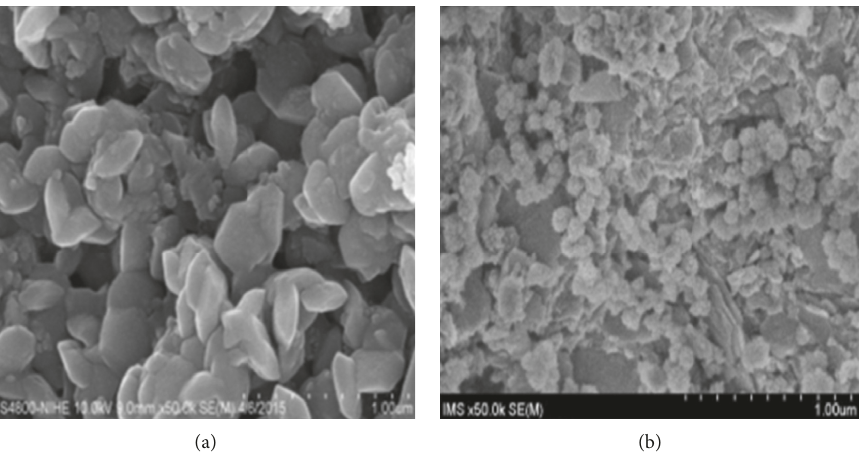
Figure 2: SEM micrographs of (a) laterite (M1) and (b) laterite after coating with MnO